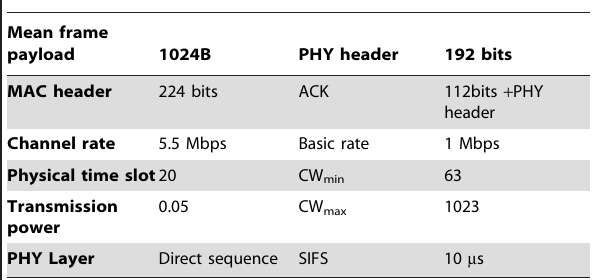
Table 2. Simulation